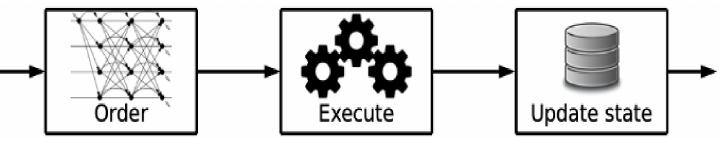
Figure 1. Order-execute architecture.